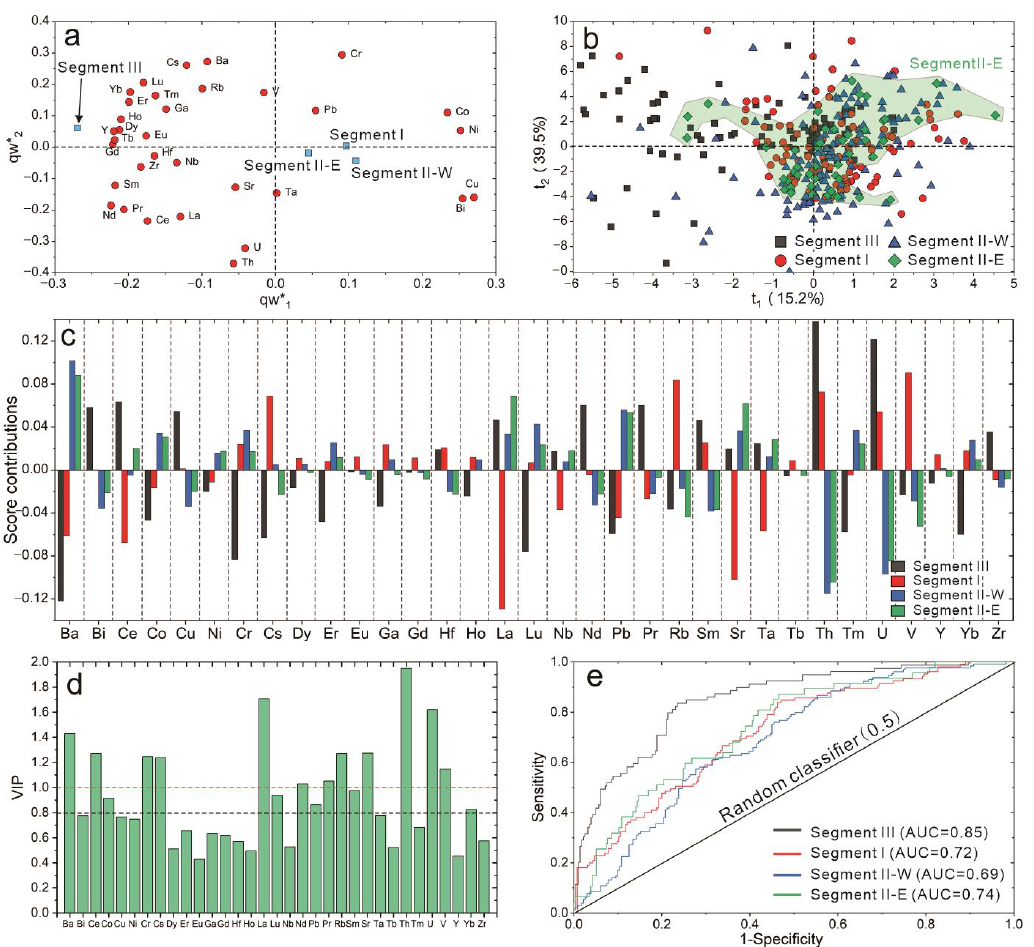
Figure 9. PLS-DA of whole-rock trace element data in each segment from the Jinchuan deposit. ( a ) The qw* 1 –qw* 2 loadings plot; ( b ) The t 1 –t 2 score plot; ( c ) The score contributions plot; ( d ) The VIP plot and ( e ) ROC curve.